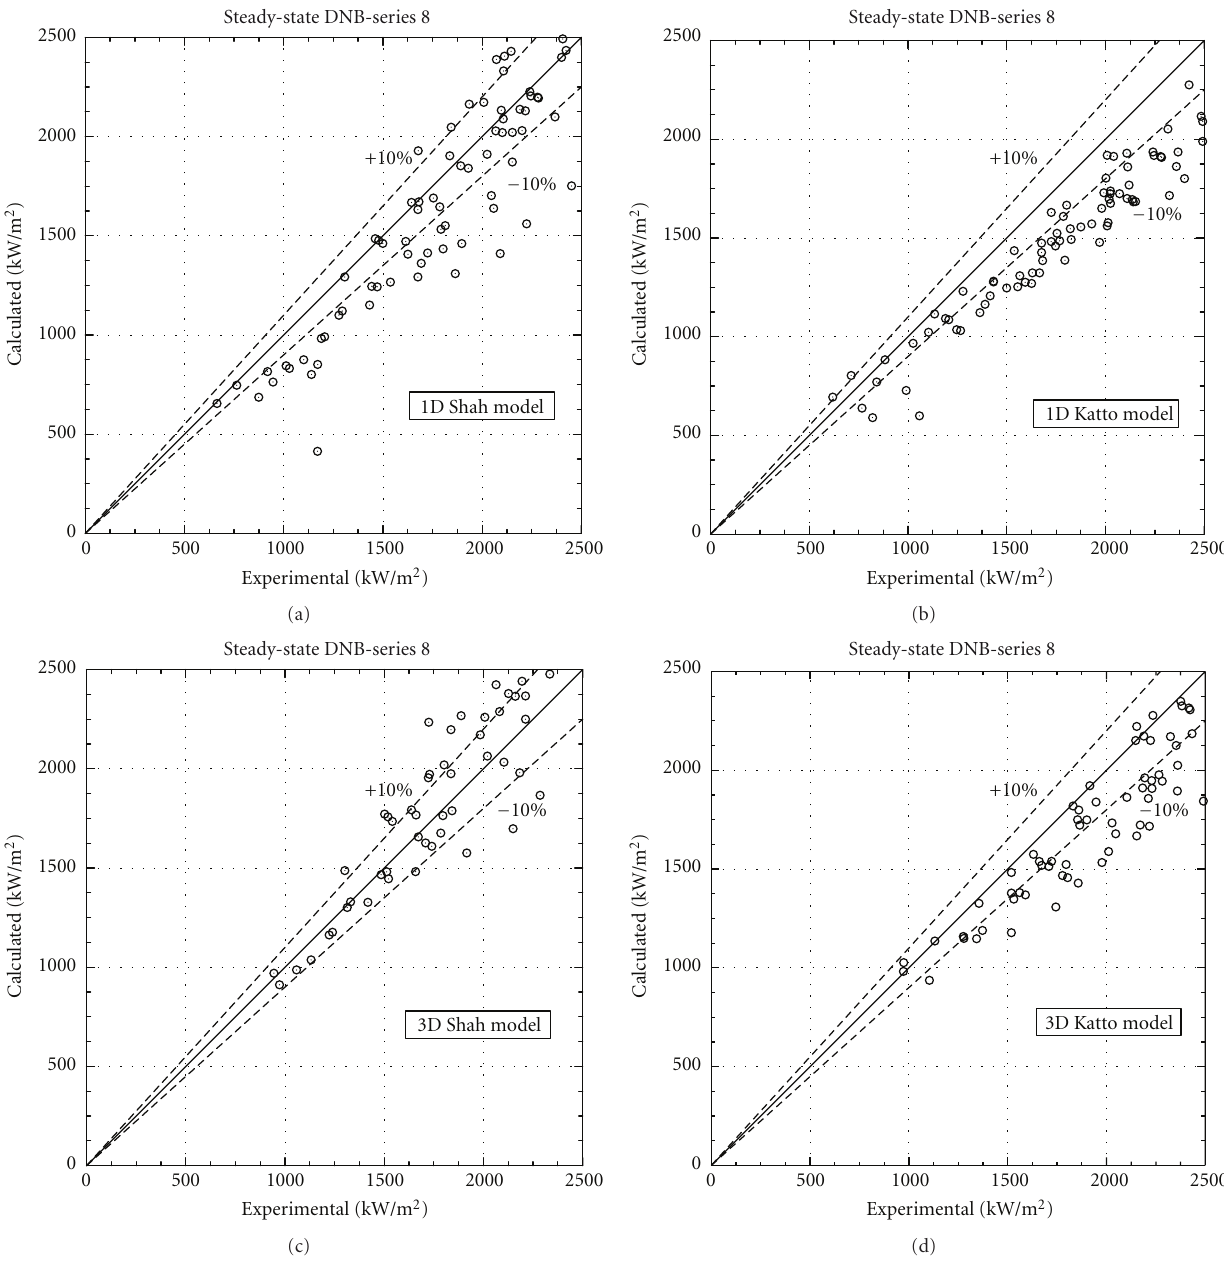
Figure 12: Computed versus experimental critical heat fluxes (Series